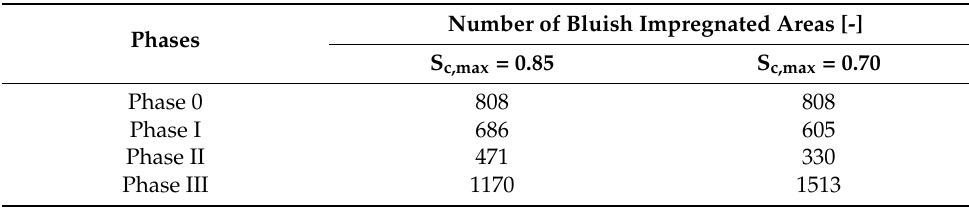
Table 3. Mean numbers of bluish impregnated areas at points of